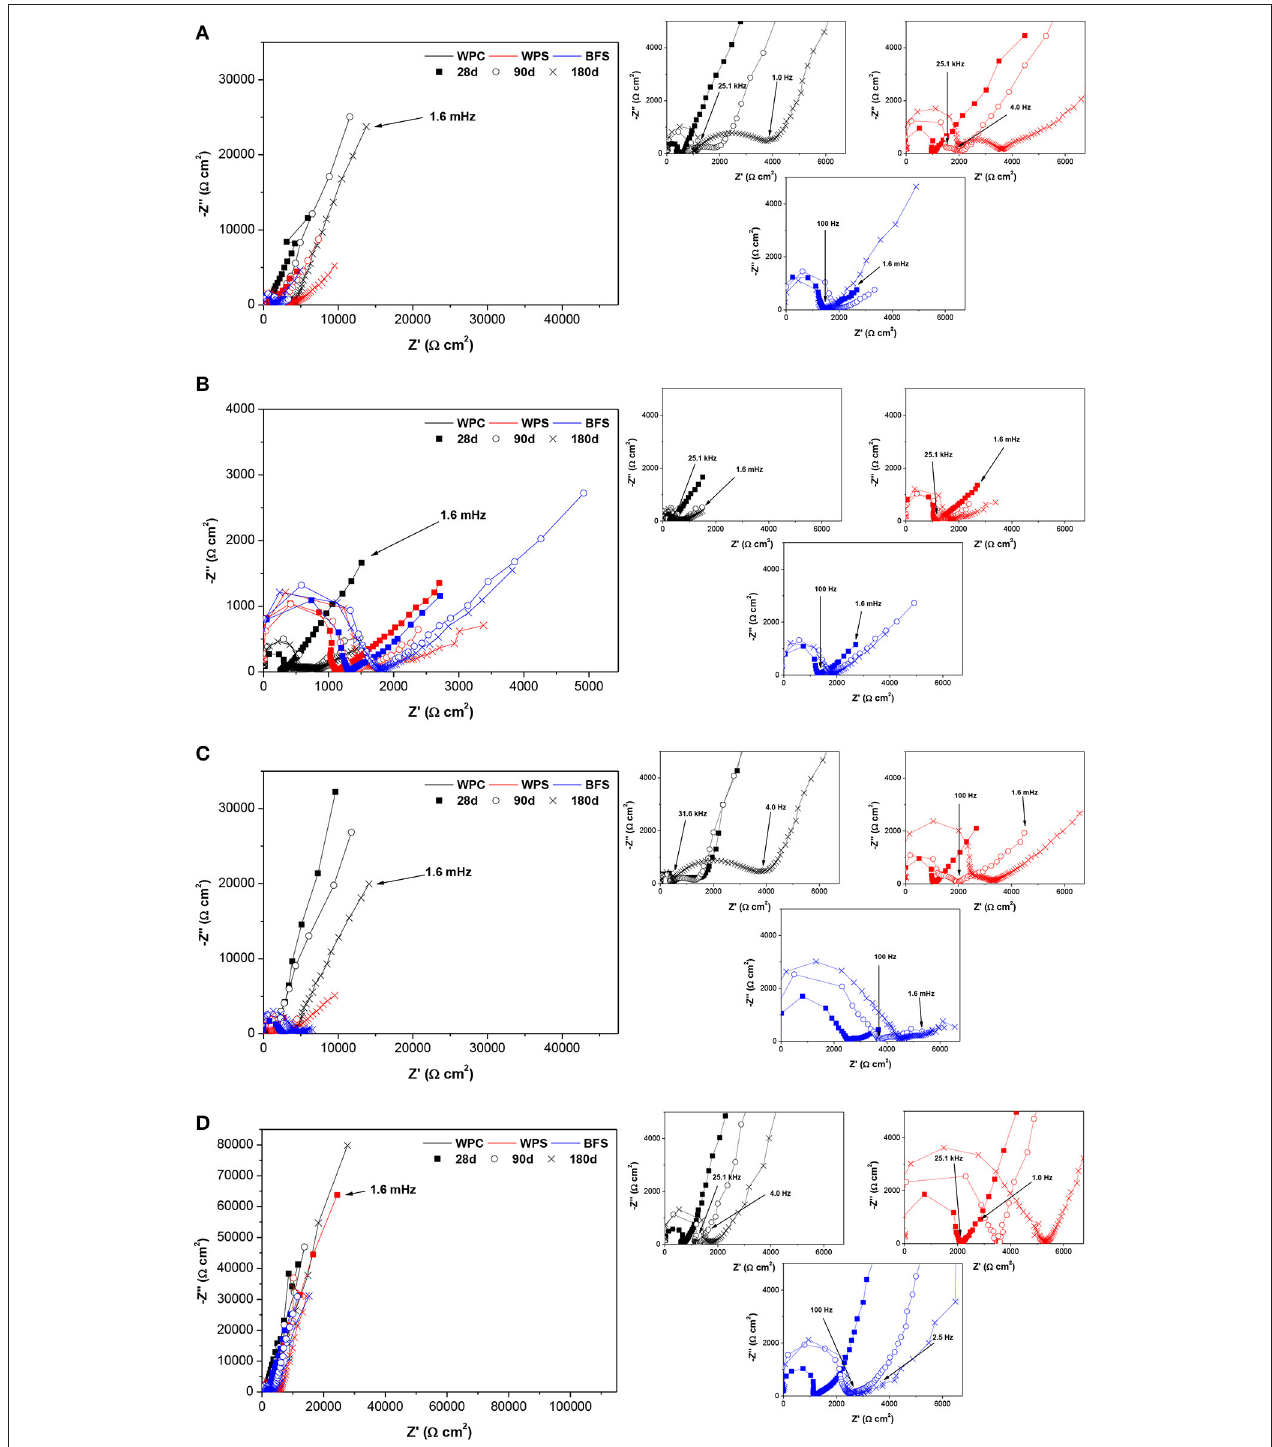
FIGURE 7 | Nyquist plots for BFS, WPS, and WPC mortars immersed in (A) alkaline solution, (B) alkaline chloride-rich solution, (C) water, and (D) exposed to standard laboratory conditions. In each part of the graphic, all data are shown overlaid for comparison in the left panel, and the smaller plots to the right show individually the time-dependence of the data obtained for each mortar